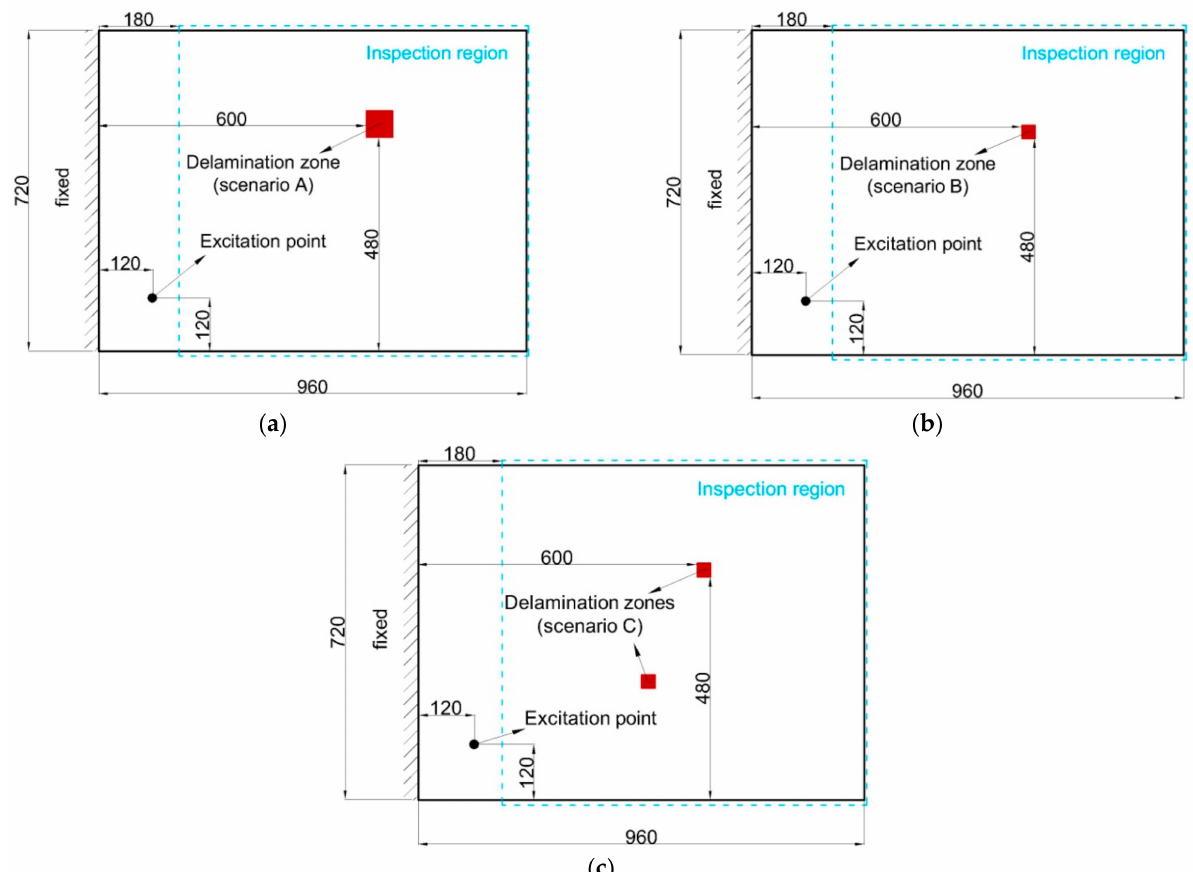
Figure 5. The dimensions of the laminate and delaminations in scenarios ( a ) A, ( b ) B and ( c )